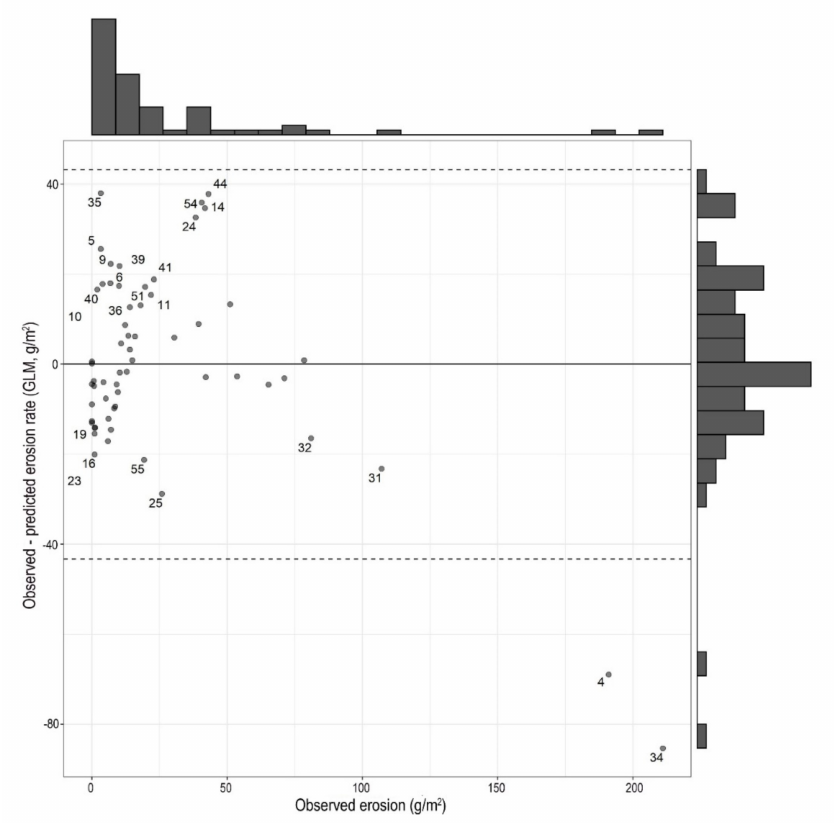
Figure 9. Bland–Altman diagram of the general linear model (GLM) prediction with cross validation (RCV) approach based on 50 repetitions (...: zero di ff erence; –: mean, - - -: 2 × standard deviation, labelled cases: di ff erence was larger than 2 × SD of the RFR model, i.e.,